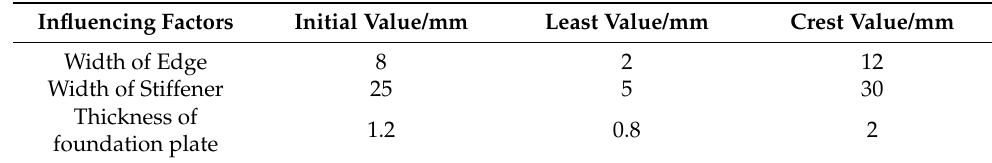
Table 2. Value range of structural optimization design variables.